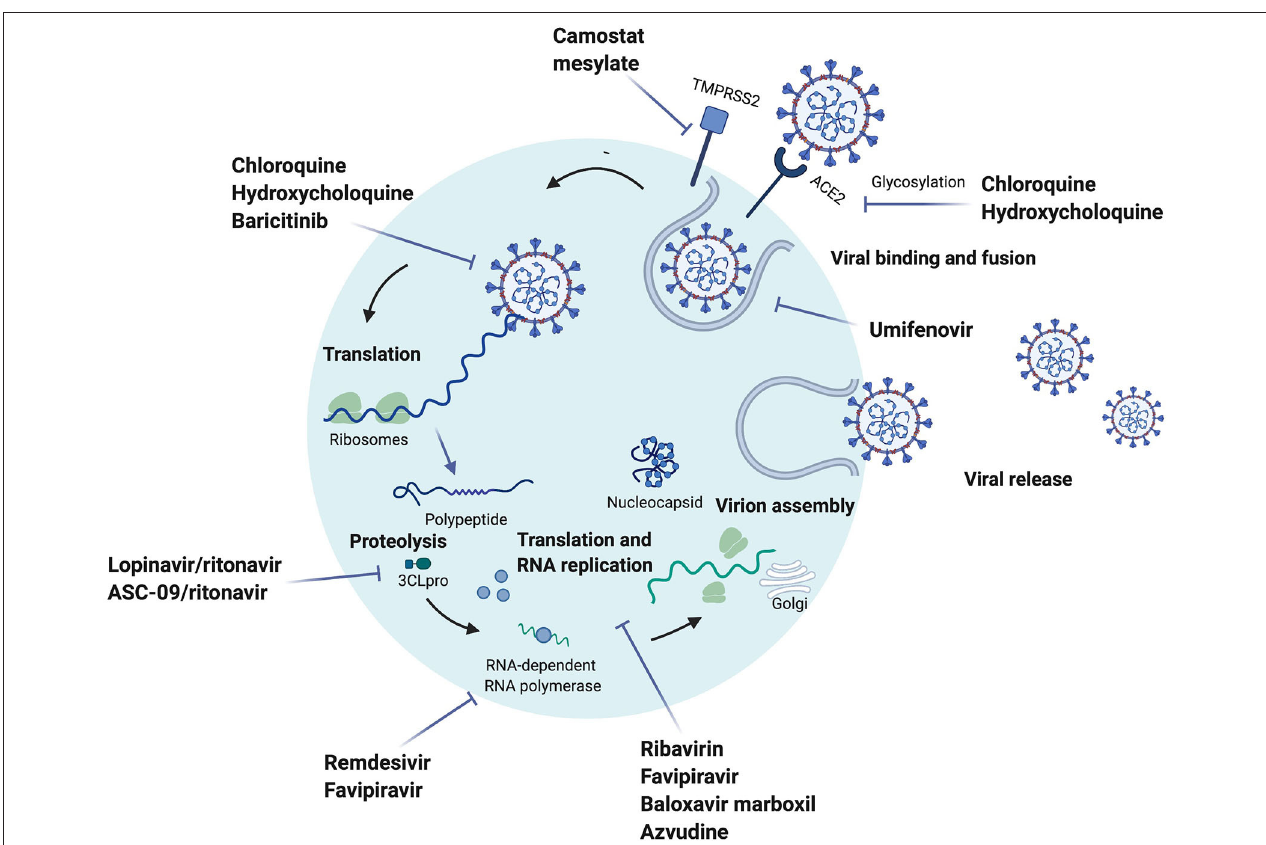
FIGURE 3 | Drugs under investigation for potential use for Coronavirus disease-19 targeting SARS-CoV-2 and their proposed mechanism of action. Umifenovir inhibits the fusion of the virus to the cell (119, 120). Camostat mesylate inhibits the cellular serine protease TMPRSS2, which has been suggested to be a potential entry of the virus ( 8, 119). Chloroquine (CQ)/hydrochloroquine (HCQ) mechanism of action is still unclear, however it has been suggested that the drug inhibits the glycosylation of ACE2, and disrupts the late stages of viral entry ( 119, 121–123). Baricitinib is suggested to have an effect on the endocytosis due to the inhibition of AP-2-associated protein kinase 1 (119, 124). Lopinavir/ritonavir and ASC-09/ritonavir are protease inhibitors, lopinavir/ritonavir is inhibiting the 3CLpro proteinase, which is translating the polypeptide from the genomic RNA ( 125). Remdesivir is an adenosine analog that moves into the viral RNA and inhibits the RNA-dependent RNA polymerase, which stops the RNA synthesis (119, 126). Baloxavir marboxil, in the influenza virus, inhibits the protein cap-dependent endonuclease, which results in inhibiting viral transcription ( 127). Azvudine is a nucleoside reverse transcriptase inhibitor that potentially affects the replication of SARS-CoV-2 (128). A proposed mechanism of action for favipiravir is the inhibition of the viral RNA synthesis due to its wide anti-RNA virus activity, it is known to also inhibit the RNA-dependent RNA polymerase ( 129, 130). Ribavirin has a broad antiviral activity, it is suggested to have an indirect effect on the RNA replication (131). The figure was created with Biorender.com.